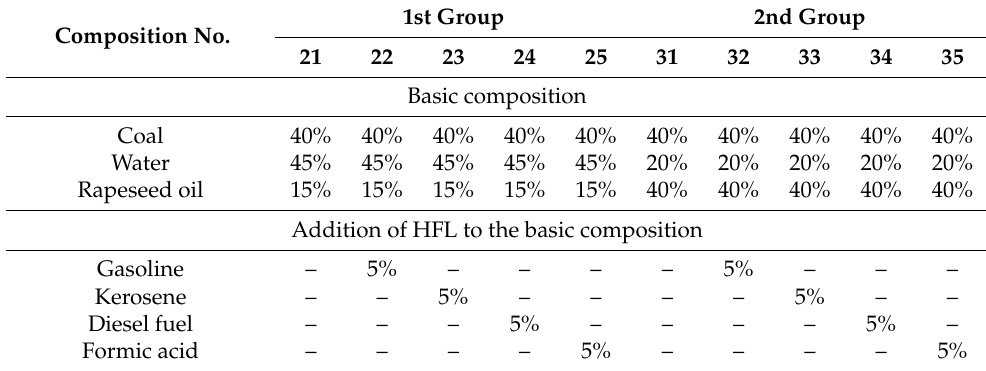
Table 5. Compositions of composite fuels with the addition of flammable liquids.